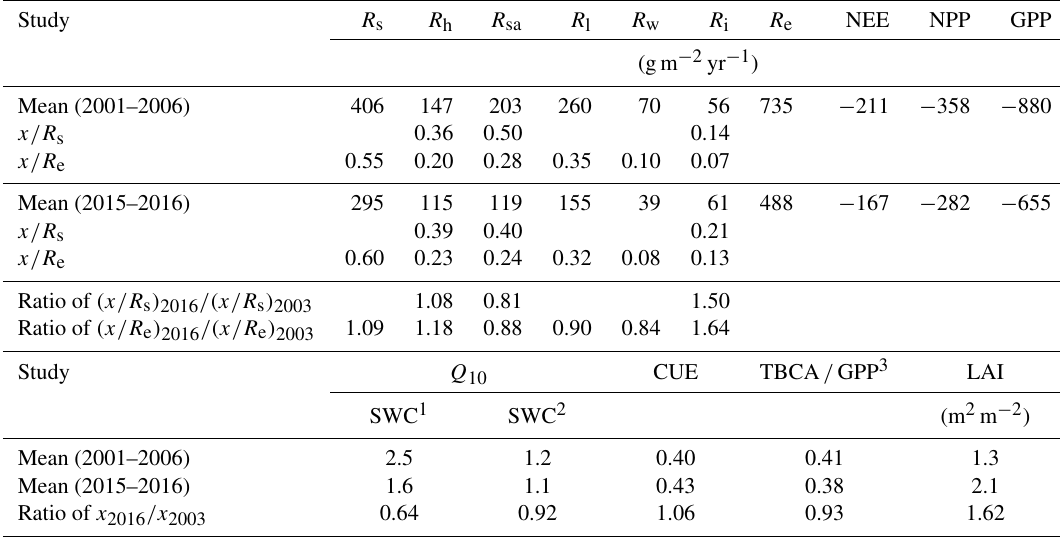
Table 3. Mean annual values of ecosystem respiration ( R e ), its components and associated ratios, net ecosystem exchange (NEE; from eddy covariance), net primary productivity (NPP), gross primary productivity (GPP), carbon-use efficiency (CUE), leaf area index (LAI), and ratio of total belowground carbon allocation (TBCA) to GPP (TBCA/GPP) in the present study (mean of November 2015 to October 2016) and in comparison to results obtained previously in the same forest (2001–2006 mean values). R i , R h , R sa , R s , R l and R w denote abiotic, heterotrophic, soil autotrophic, soil, foliage, and wood CO 2 flux, respectively. Q 10 is derived during the two studies for the wet and dry